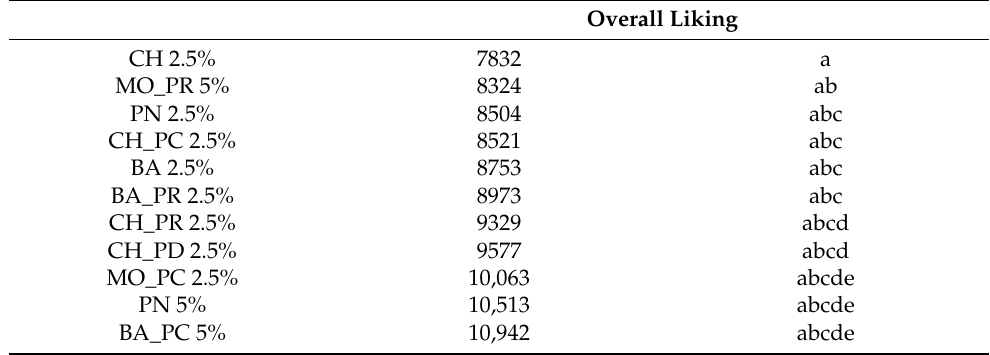
Table 7. Results (rank sums and results of Kruskal–Wallis test) of the consumer evaluation of the tofu samples obtained with the traditional and innovative coagulants at two concentrations (2.5% and